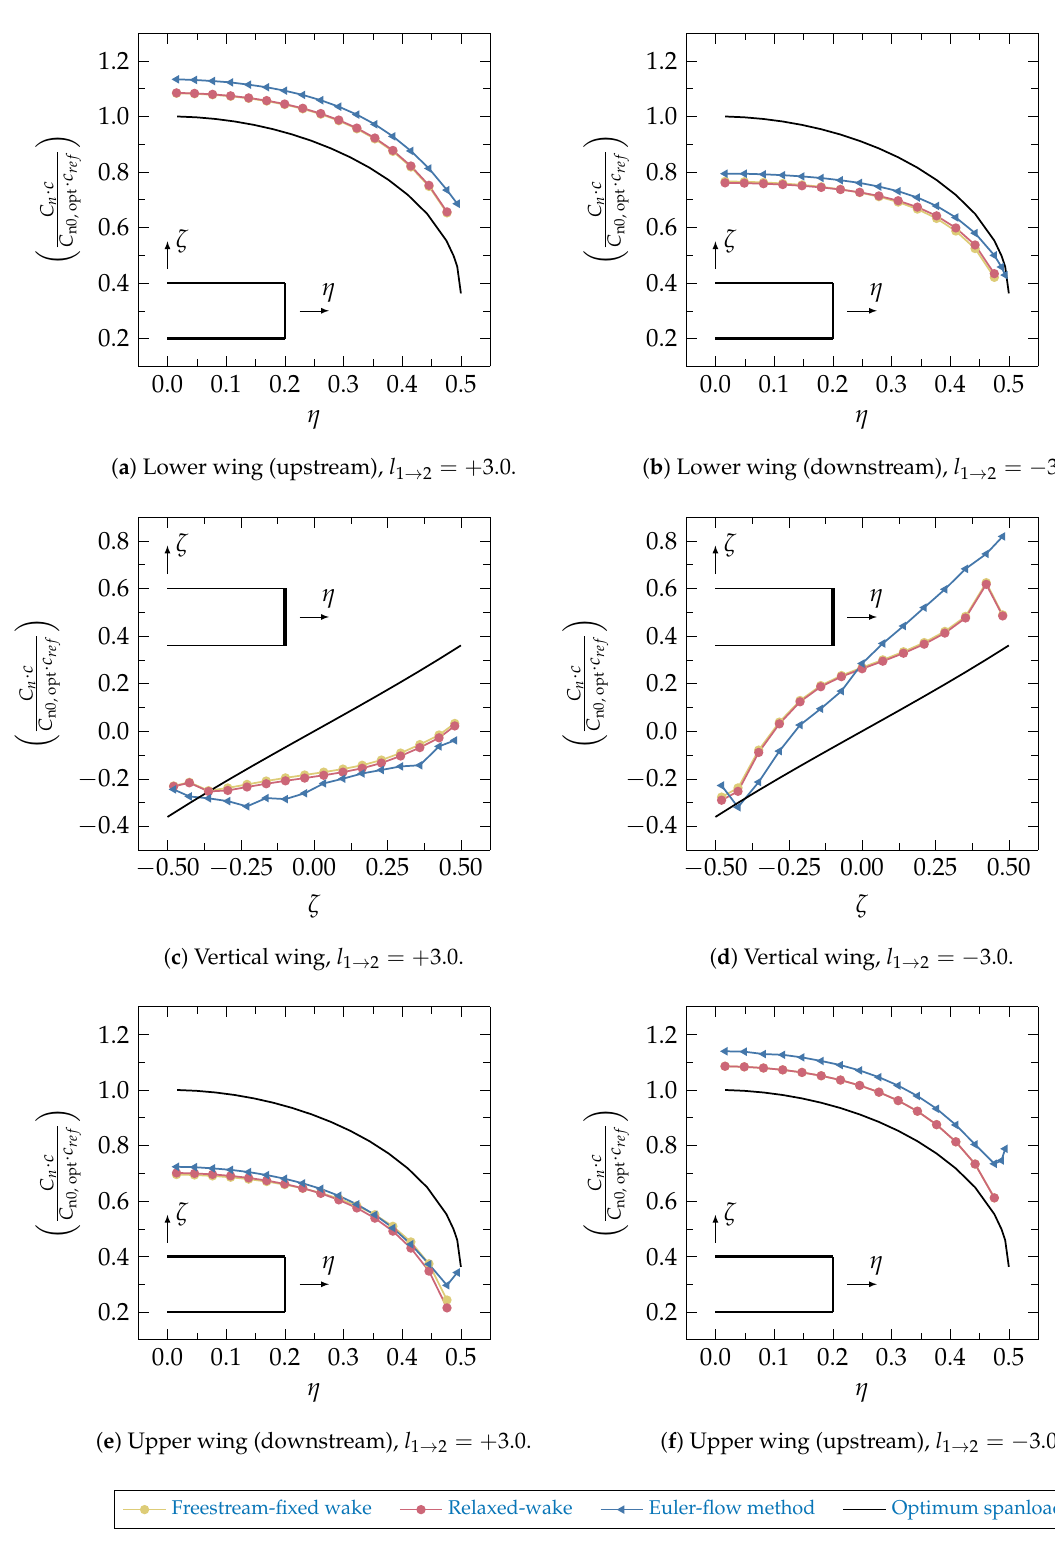
Figure 3. Spanwise load distributions at a freestream angle of attack of α = 8.0 ◦